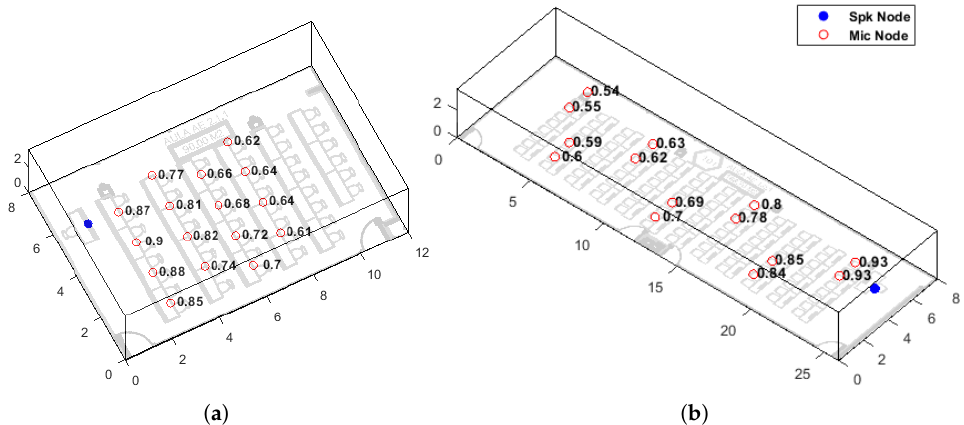
Figure 7. 3D models and SII measurement mappings in different rooms at the ETSE (( a ). Classroom 2.1.1 and ( b ). Classroom 1.0.1) . Marked positions of sound source node (blue dot) and receiver nodes (black circles).